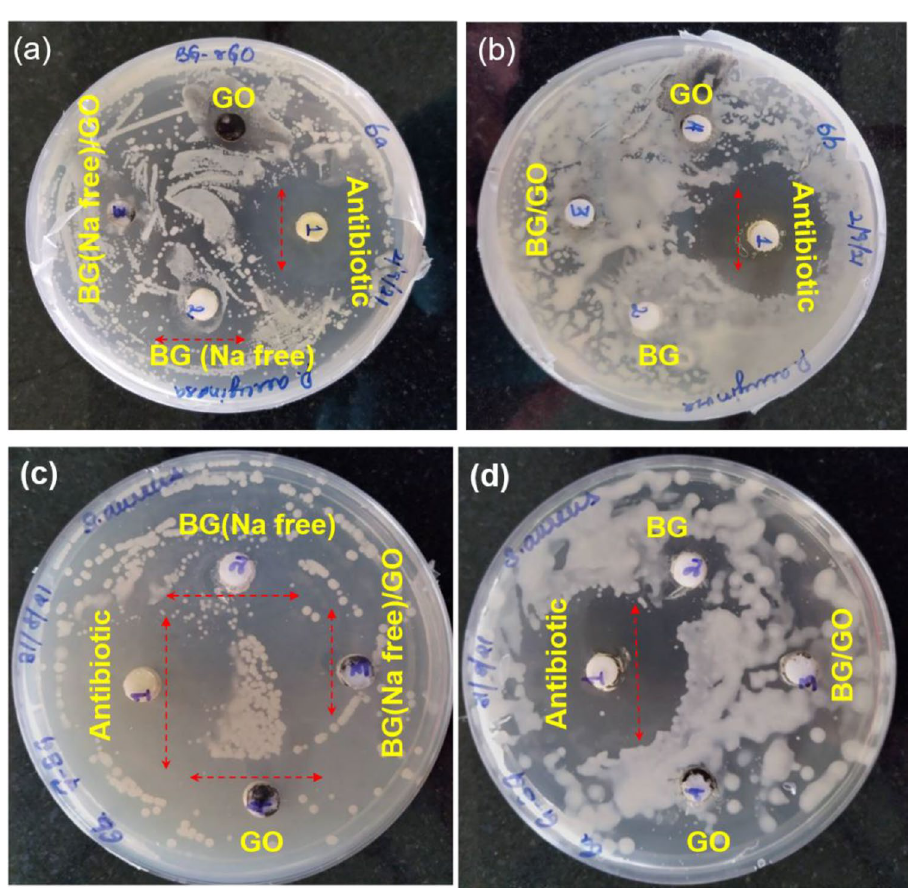
Figure 6. Photographs of antibacterial activity with ( a ) BG (Na-free), GO and BG (Na-free)/GO nanocomposite against P. aeruginosa , ( b ) BG and BG/GO nanocomposite against P. aeruginosa , ( c ) BG (Na-free), GO, and BG (Na-free)/GO nanocomposite against S. aureus , ( d ) BG and BG/GO nanocomposite against S.